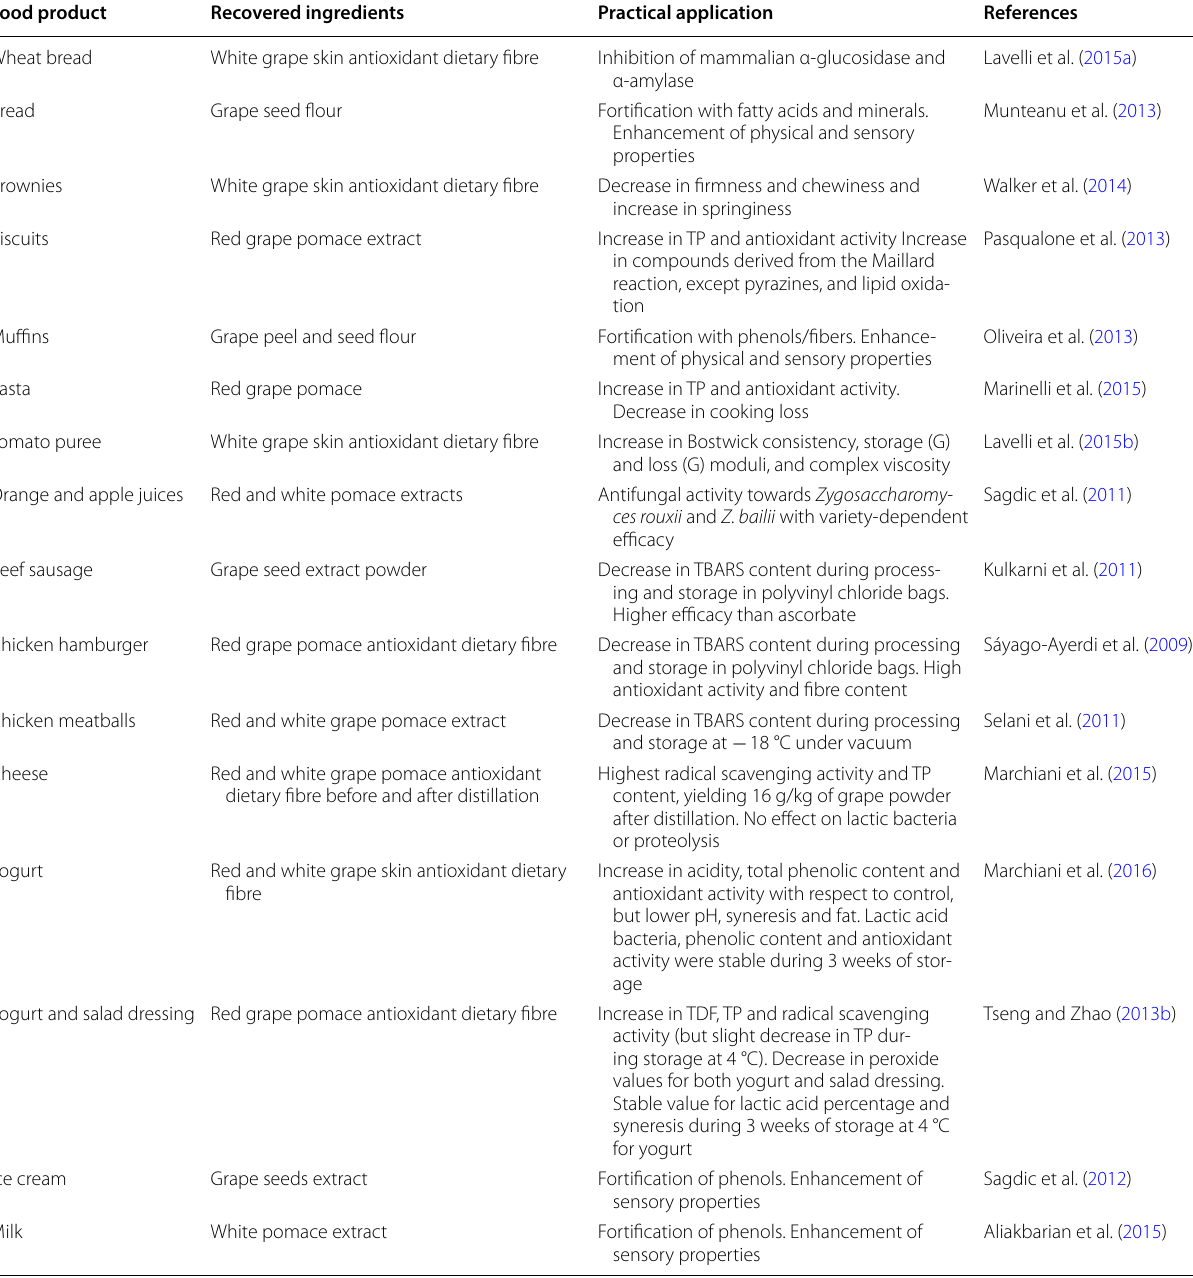
Table 2 Functions of grape pomace in food